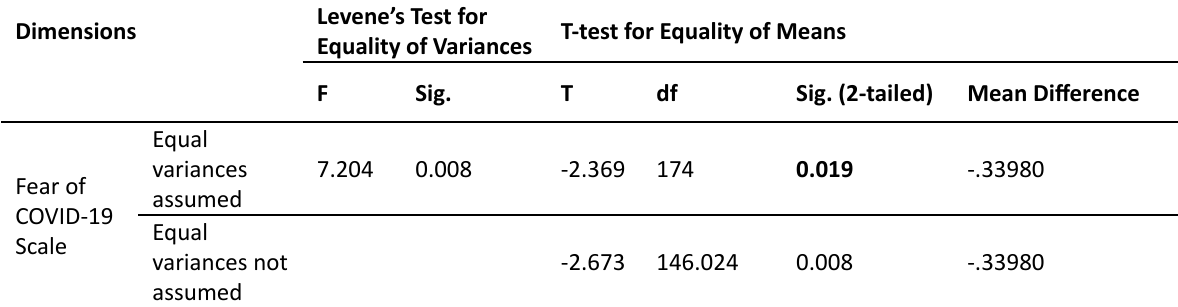
Table 3. One-Way ANOVA Test Results According to the Educational Status Variable ANOVA Fear of COVID-19 Scale